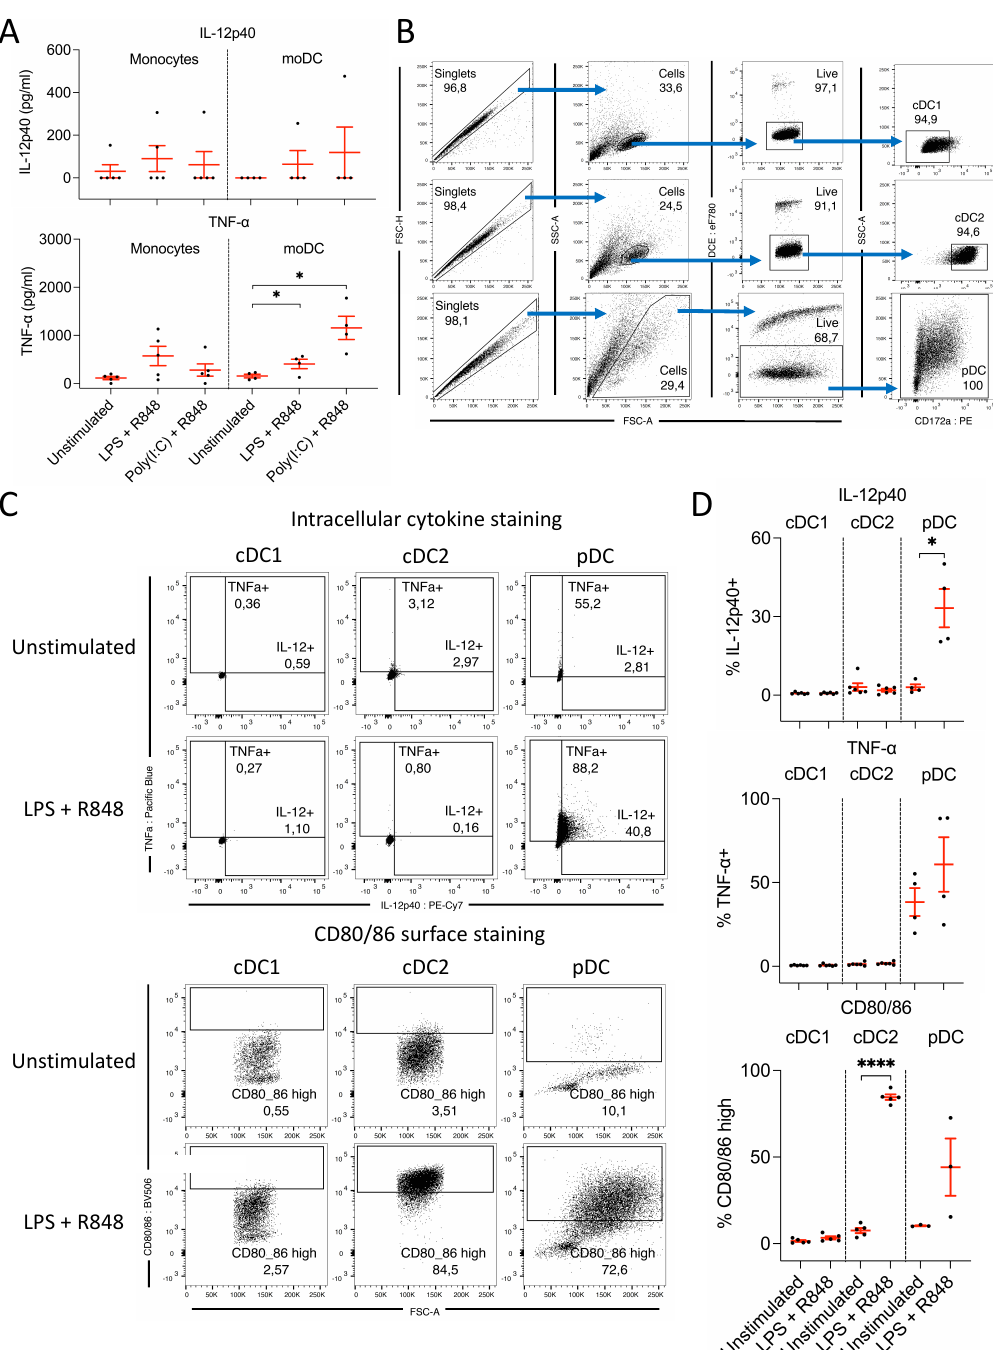
Figure 2. ( A ) Concentrations of IL-12p40 and TNF- α detected in monocyte and moDC cell culture supernatants by ELISA following 24 h of stimulation with different TLR ligand combinations. Both cytokines were quantified in parallel from the same supernatants. Monocyte stimulations were performed from n = 5 different pigs, whereas n = 4 moDC stimulations were performed. ( B ) Gating strategy used to select sorted bona fide DC subsets after stimulation, prior to FACS analysis of intracellular cytokine production and CD80/86 expression by staining for CD152muIg. ( C ) Representative FACS analysis of cDC1, cDC2, and pDC demonstrating induction of IL-12p40 and TNF- α production by pDC and CD80/86 expression by cDC2 and pDC following stimulation with LPS (100 ng/mL) + R848 (300 ng/mL). ( B , C ) FACS plots displaying forward and side-scatter values on a linear scale, while all fluorescent markers are displayed on a biexponential scale. ( D ) Summary of percentages of IL-12p40+, TNF- α +, and CD152muIg high expressing cDC1, cDC2, and pDC following 24 h of stimulation with LPS (100 ng/mL) + R848 (300 ng/mL) vs. unstimulated control. Each dot represents the result from a different pig. ( A , D ) Asterisks indicate statistical significance; paired t test; * p ≤ 0.05, **** p ≤